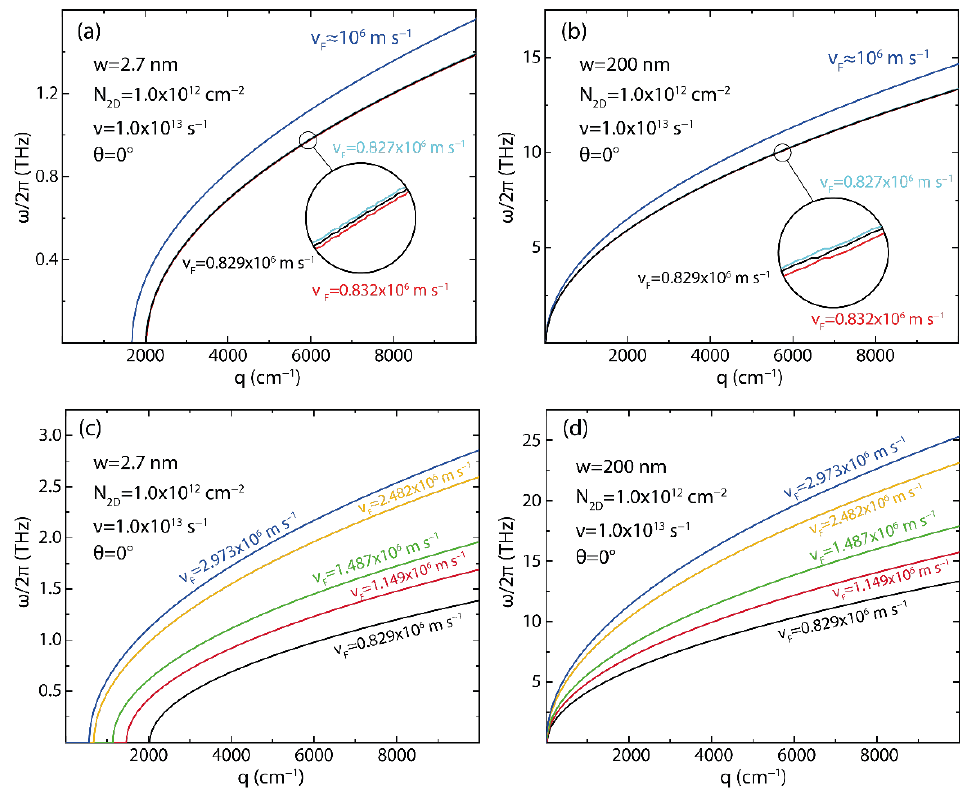
Figure 7. ( a , b ) Plasmon energy dispersion ( 𝜔/2𝜋 ) vs. wave vector ( 𝑞 ), as obtained using Equation (5) (with 𝜈 = 1.32 × 10 13 s −1 , 𝑁 2𝐷 = 1 × 10 12 cm − 2 , and 𝜃 = 0 ), considering the group velocity of the 𝜋 band ( v π = 0.827 × 10 6 m/s), the 𝜋 ∗ band ( v F−π∗ = 0.832 × 10 6 m/s), the 𝜋 / 𝜋 ∗ averaged value ( v F = 0.829 × 10 6 m/s), and the reference value v F = 10 6 m/s value, as reported in Ref. [36]. ( c , d ) The results obtained with the 𝜋 / 𝜋 ∗ averaged value ( v F = 0.829 × 10 6 m/s) are compared to those obtained employing the experimental Fermi velocities measured in graphene synthesized on different substrates, as reported in Ref. [53]. For the analysis shown in this Figure, we selected the narrowest ( 𝑤 = 2.7 nm, panels a and c ) and the widest ( 𝑤 = 200 nm, panels b and d ) ribbons included in this study.